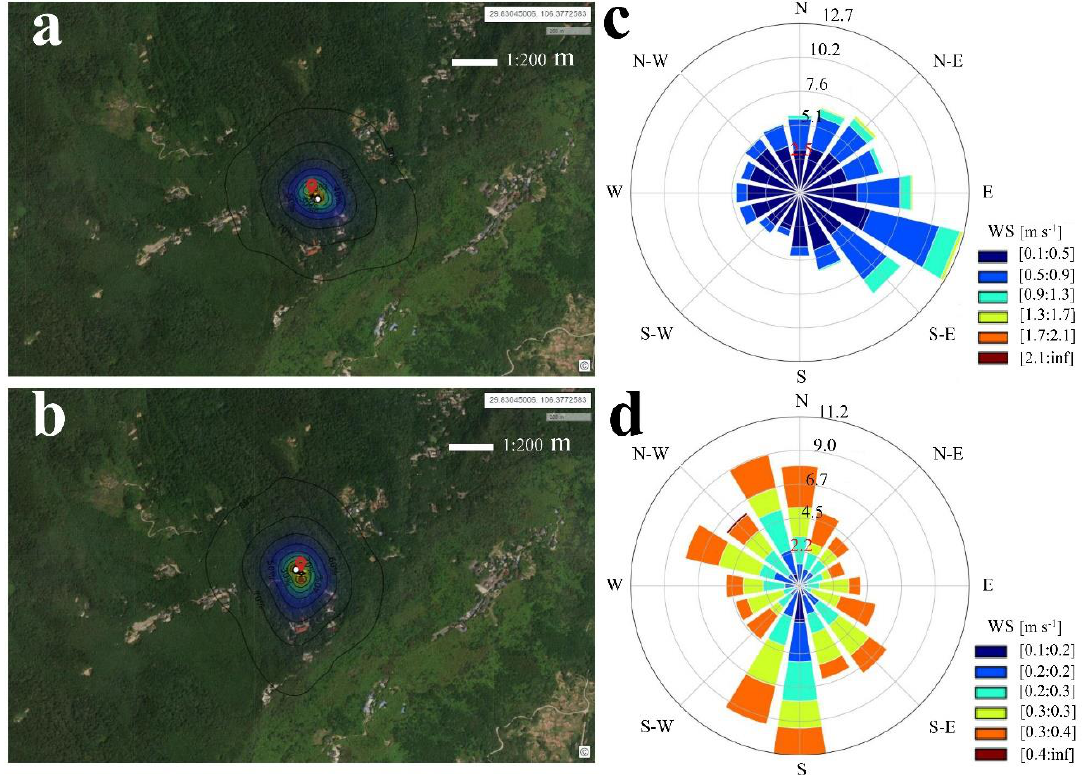
Figure 2. Footprint and wind rose. ( a ) Footprint of EC system at 35 m; ( b ) Footprint of EC system at 25 m; ( c ) Wind rose of EC system at 35 m; ( d ) Wind rose of EC system at 25 m. WS represents wind speed.